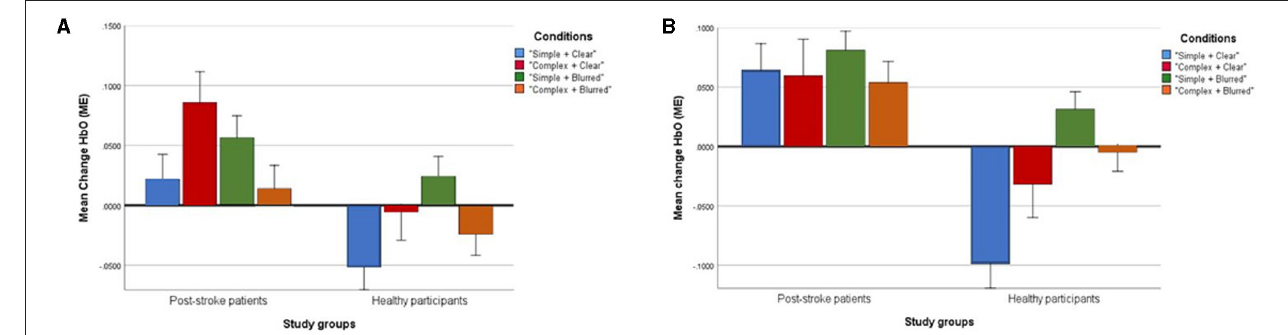
FIGURE 4 | Profile plots showing changes of mean [HbO] (ME) in ipsilesional/ipsilateral Precuneus (A) and contralesional/contralateral Precuneus (B) in four experimental conditions between post-stroke patient and healthy groups (unit, µ Mol/L).